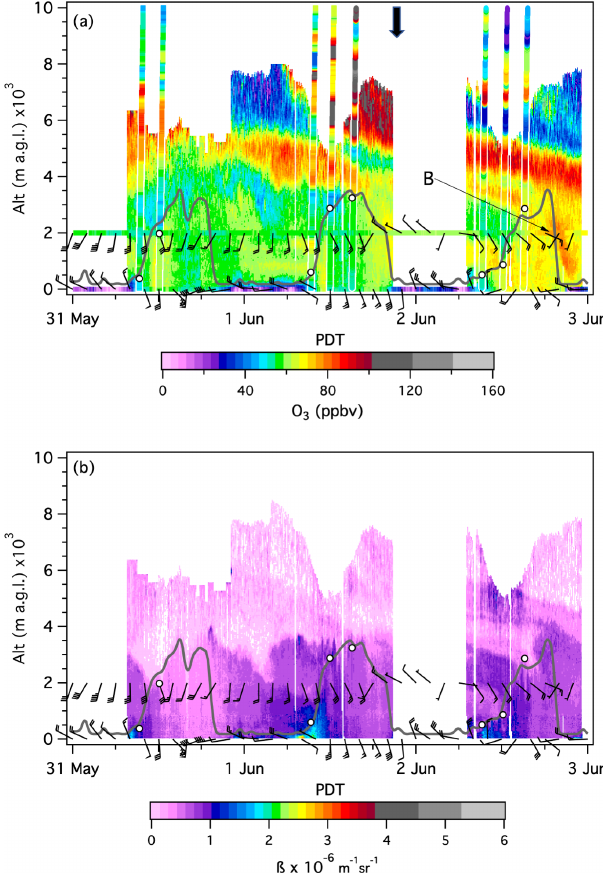
Figure 11. Time–height curtain plots similar to those in Figs. 4 and 5, but expanded to better show the TOPAZ (a) ozone and (b) backscatter measurements during IOP1. The dark-gray curves represent the boundary layer heights derived from the co-located Doppler lidar measurements. The superimposed horizontal bands in (a) show the AP and NLVA in situ O 3 measurements, and the near- vertical colored bands show the Joe Neal ozonesonde profiles. The barbs in both panels show the AP and NLVA surface winds and the open circles the mixing heights inferred from the ozonesondes. The heavy black arrow above (a) corresponds to the 12:00UT 25 May PV plot from Fig. 3b. The 300hPa surface lies at approximately 9kma.g.l. The label “A” is the same as in Fig. 6.